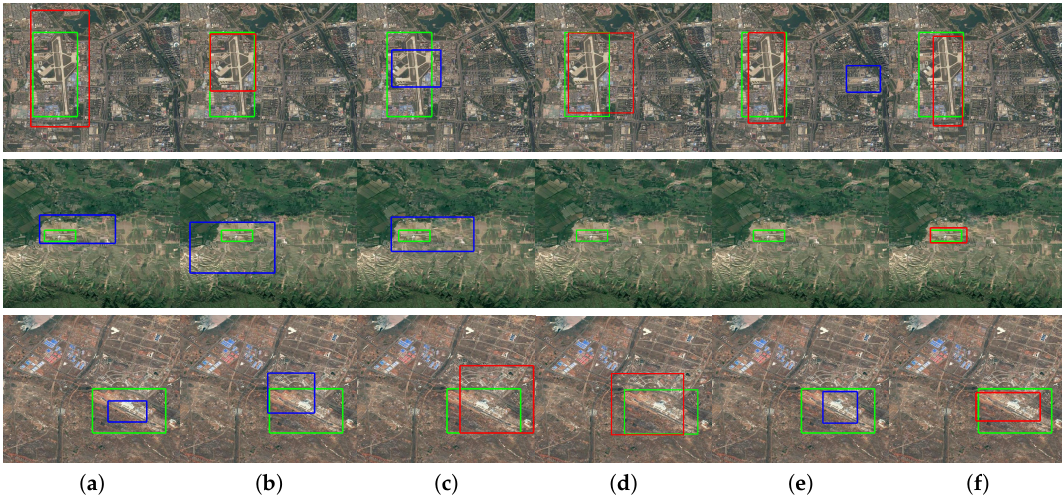
Figure 12. Detection results of different airport detection methods. The true positives, false positives, and ground-truths are indicated by red, blue and green rectangles, respectively. ( a ) BU and TD saliency [12]. ( b ) Saliency and CRF [13]. ( c ) HRL [1]. ( d ) CNN with USB-BBR [26]. ( e ) Faster R-CNN [19]. ( f ) our